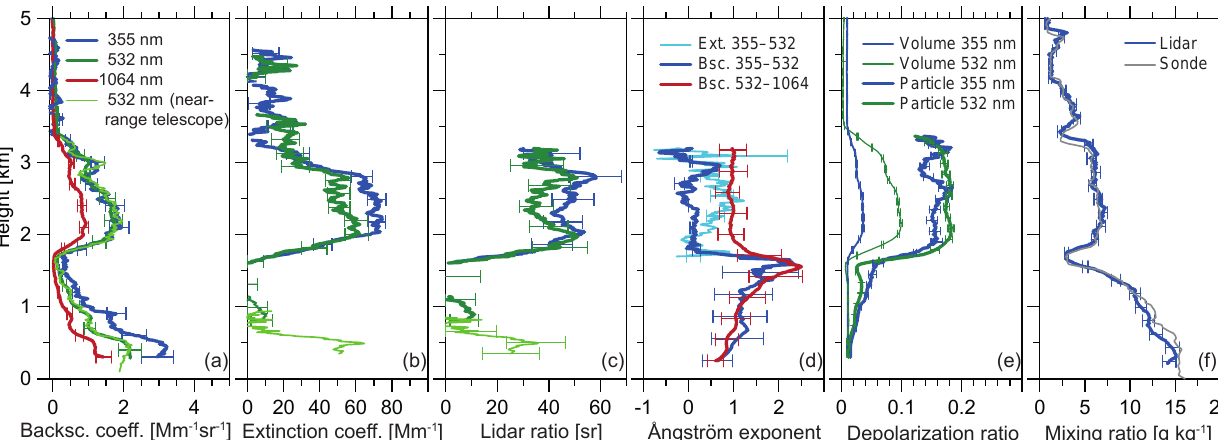
Figure 12. Optical and meteorological products obtained on board of RV Meteor between 23:15 and 23:58UTC on 9 May 2013. A Saharan dust plume above the marine boundary layer was tracked. Shown are from left to right the particle backscatter coefficient, the particle extinction coefficient, the corresponding lidar ratios and Ångström exponents, the volume and particle linear depolarization ratios, and the water-vapor mixing ratio. The error bars for the water vapor, the extinction, and backscatter coefficients include the signal-noise and for the latter one also the Rayleigh-calibration errors. Those errors propagate to lidar ratio and Ångström exponent. The error bars of the depolarization ratio additionally include the calibration error of C , the uncertainties of R i , and for the particle depolarization also the uncertainty of the backscatter